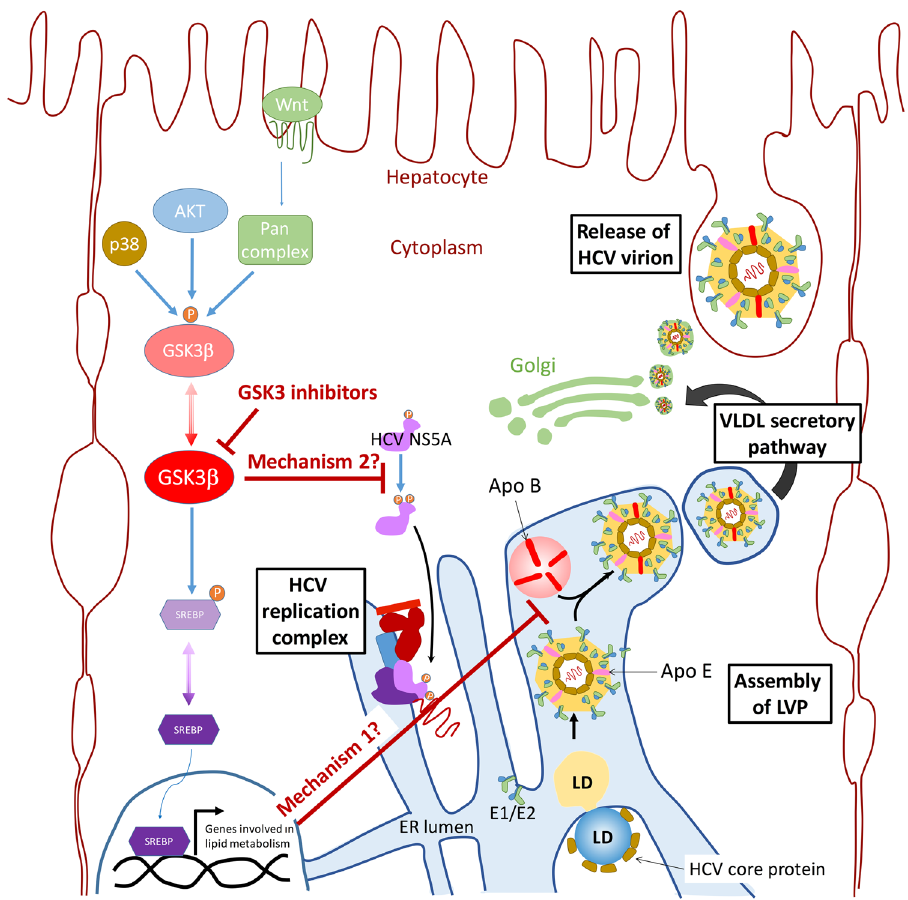
Figure 8. Proposed model for the effects of GSK3 β inhibitors on HCV virion particles’ assembly/release. GSK3 β is an important kinase that is capable of phosphorylating a few hundreds of proteins, including SREBP-1 and acyl-CoA synthetase 3 (ACSL3) which are involved in lipid metabolic pathways 23, 32 . The phosphorylated (inactive) form is downstream the canonical Wnt pathway, which is stimulated by various signals/stimuli, as well as the p38 protein and AKT 33 . The adherence of HCV virion assembly to the host cell’s lipid metabolism and secretory pathways renders it sensitive to lipid perturbations 34 . The effect of GSK3 β enzymes and transcription factors involved in lipid metabolism hinders the assembly/release of HCV LVPs (potential mechanism 1). GSK3b is also a member of the cyclin-dependent kinase CMGC family. Members of this family were shown to be involved in the phosphorylation of HCV non-structural protein 5A (NS5A), which is an integral part of the HCV replication complex 31 . Similarly, GSK3 β inhibitors may interfere with this process, representing another potential mechanism for inhibition of HCV (potential mechanism 2). * The diagram is a schematic drawing and is not proportionate to the real